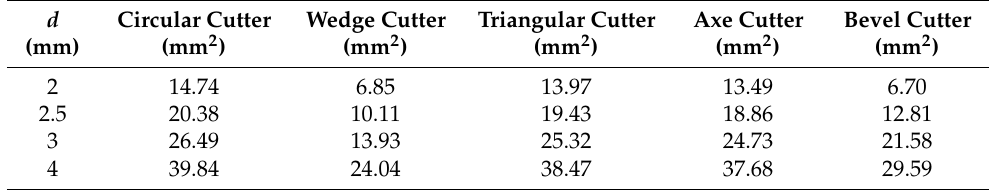
Table 1. Statistical table of the change in rock breaking area of the PDC cutters with the penetra- tion